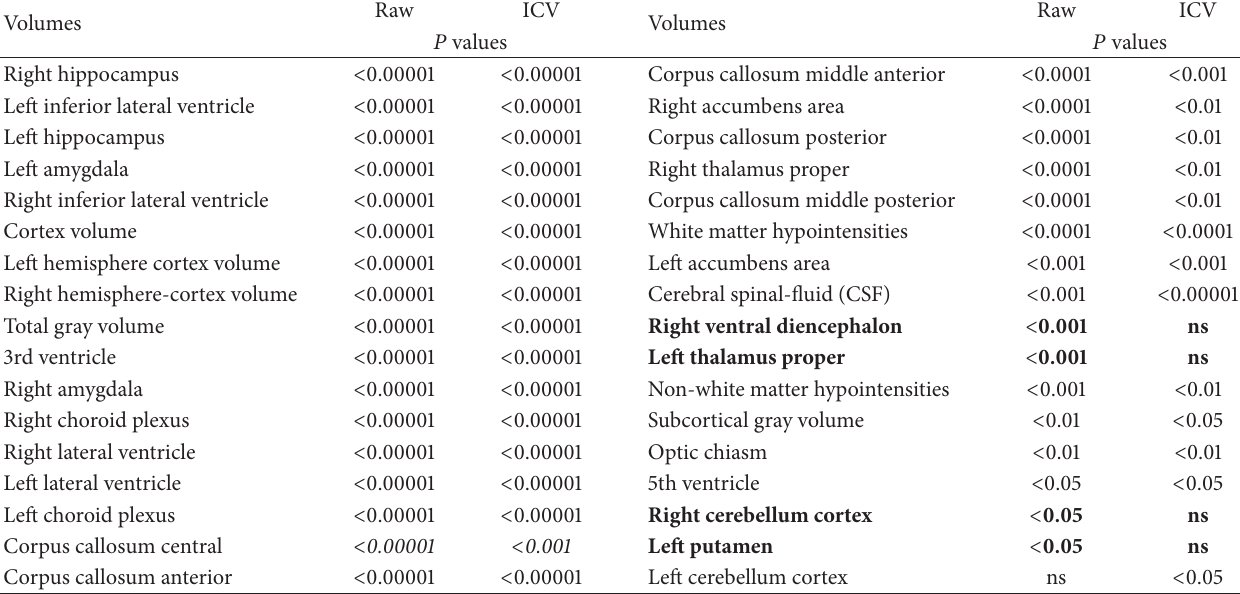
Table 6: Univariate analysis of subcortical volumes using different normalization approaches for AD versus CN ∗ .